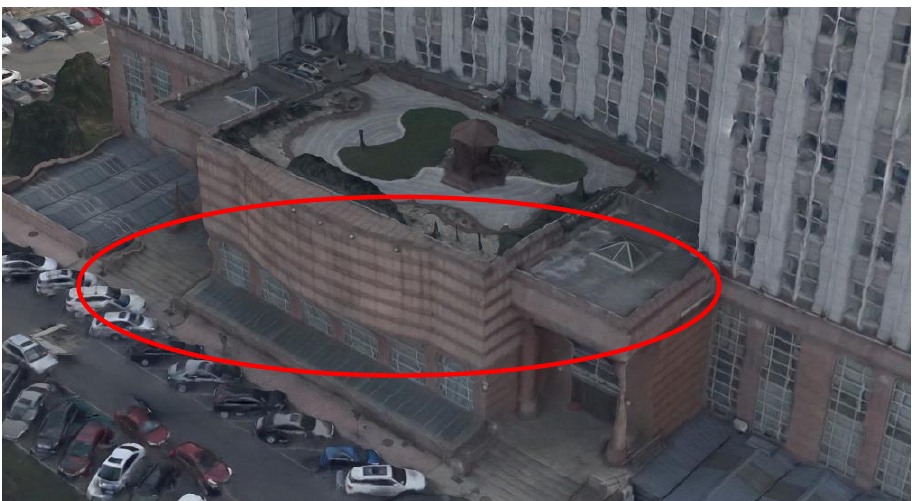
Figure 12 The air view of one big building model produced by OP only